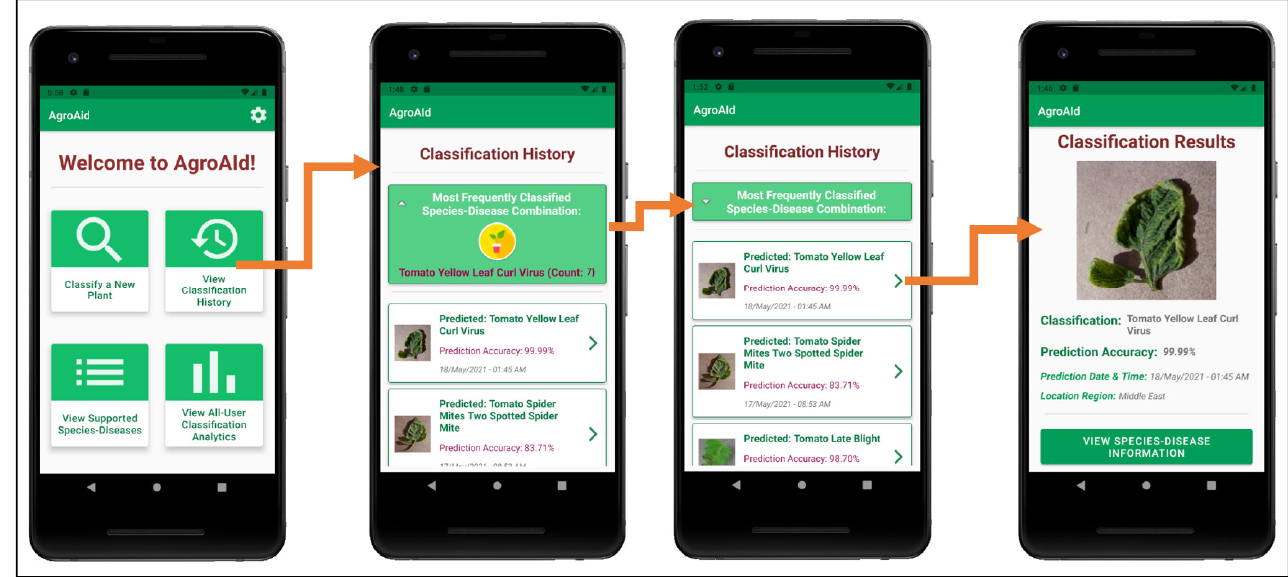
Figure 29. Viewing a user’s classification history, with its minimizable “frequent classification” card, and an example of expanding the details of a history record.